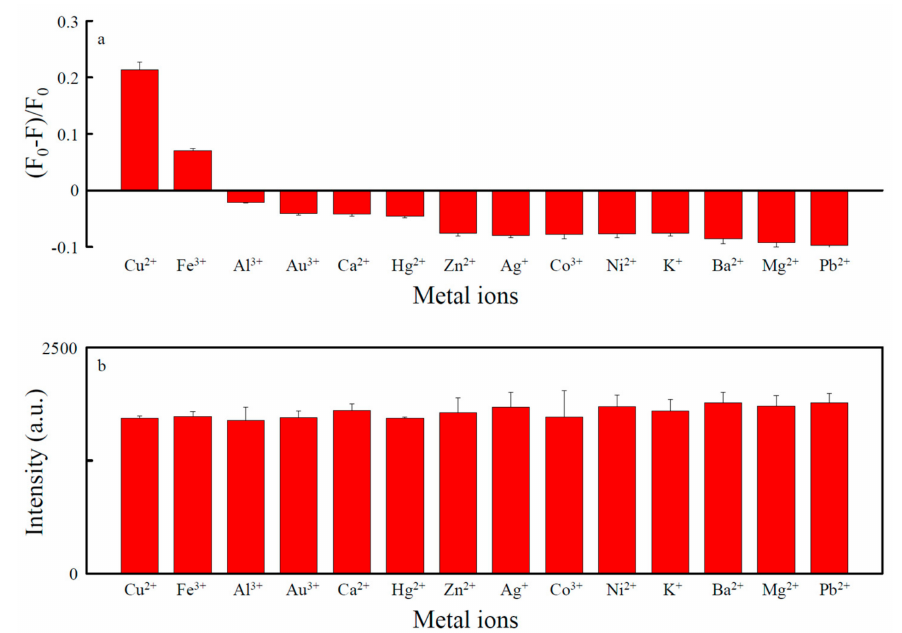
Figure 4. ( a ) Selectivity of the CDs as a probe for metal ions (10.0 µ M) in a Tris–HCl bu ff er (1.0 mM, pH 6.0); ( b ) response profiles of the CDs by Cu 2 + in the presence of di ff erent metal ions in a Tris–HCl bu ff er (1.0 mM, pH 6.0).